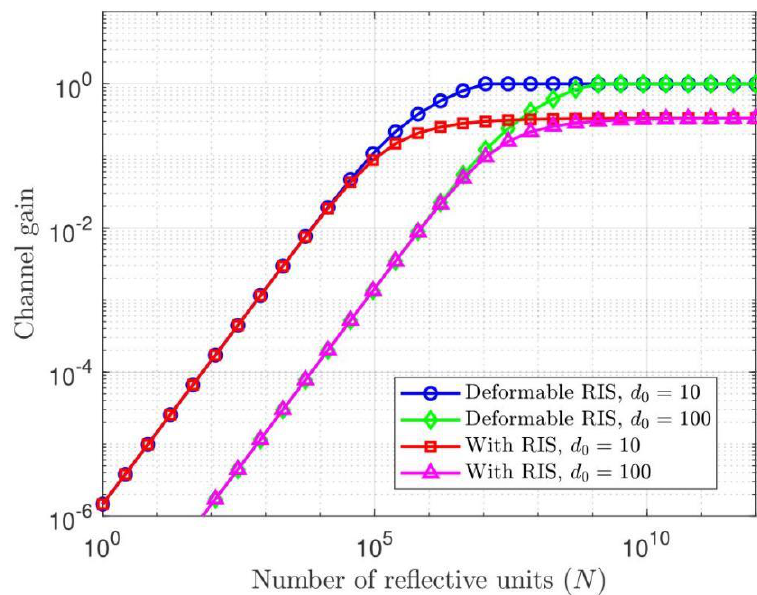
Figure 9. Channel gain of the wireless channel between BS and RIS.